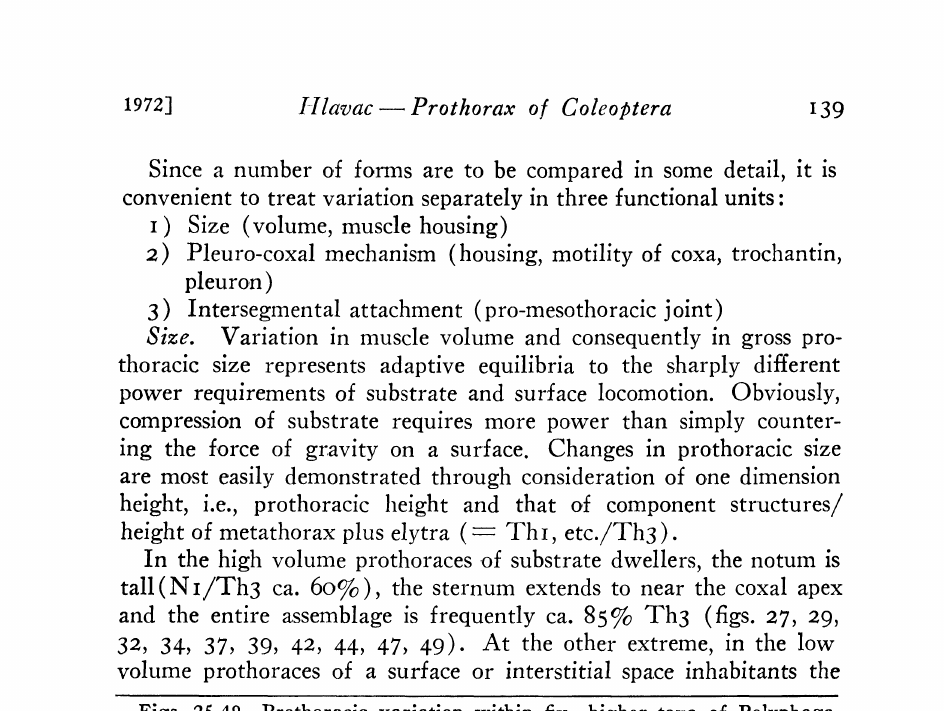
Figs. 25-49. Prothoracic variation within five higher taxa of Polyphaga. Each set, bounded by brackets, compares two forms differing widely in prothoracic volume and consists of five figures" a pair of lateral views, drawn parallel to the coxal lorg axis, a smaller pair of posterior views and a set of graphs comparing the height, length and width of the pro- thorax with the dimensions of the metathorax. The set on the left, e.g. fig. 29A, contrasts the cumulative heights of prothoracie structures expressed as a percentage of height of metathorax plus elytra, measured at the level of the posterior edge of the noto-sternal joint, and depicted in the same order as the drawings. While the paired, crossed lines on the right, e.g. fig. 29B, contrast the length (vertical line) and width of the pronotum expressed as a percentage of maximum width of metathorax plus elytra; the percentage scale on the right applies here as well. Figs.